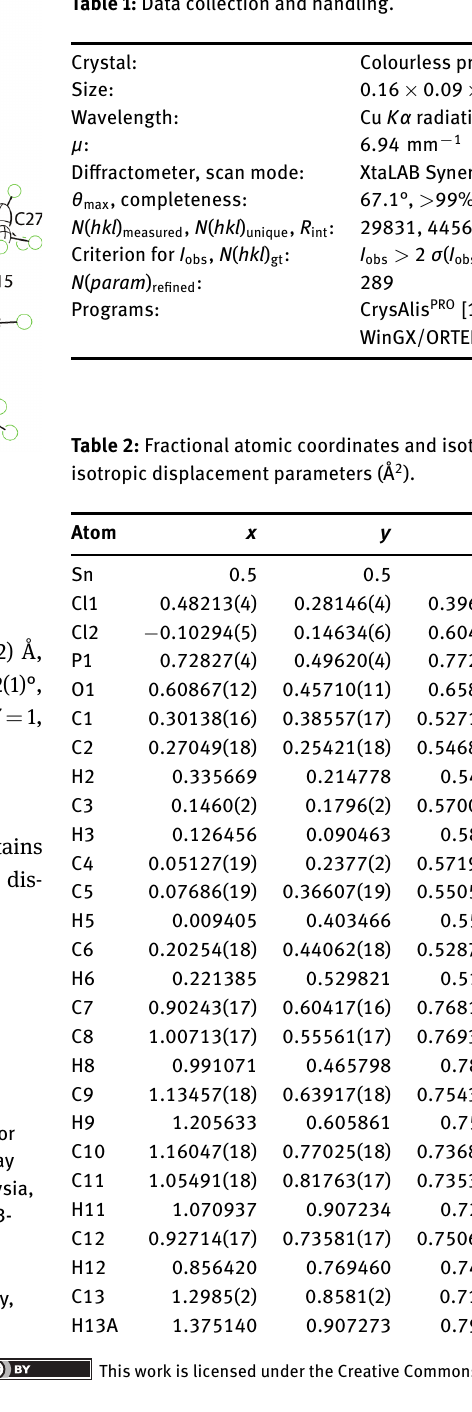
Table 1: Data collection and handling.